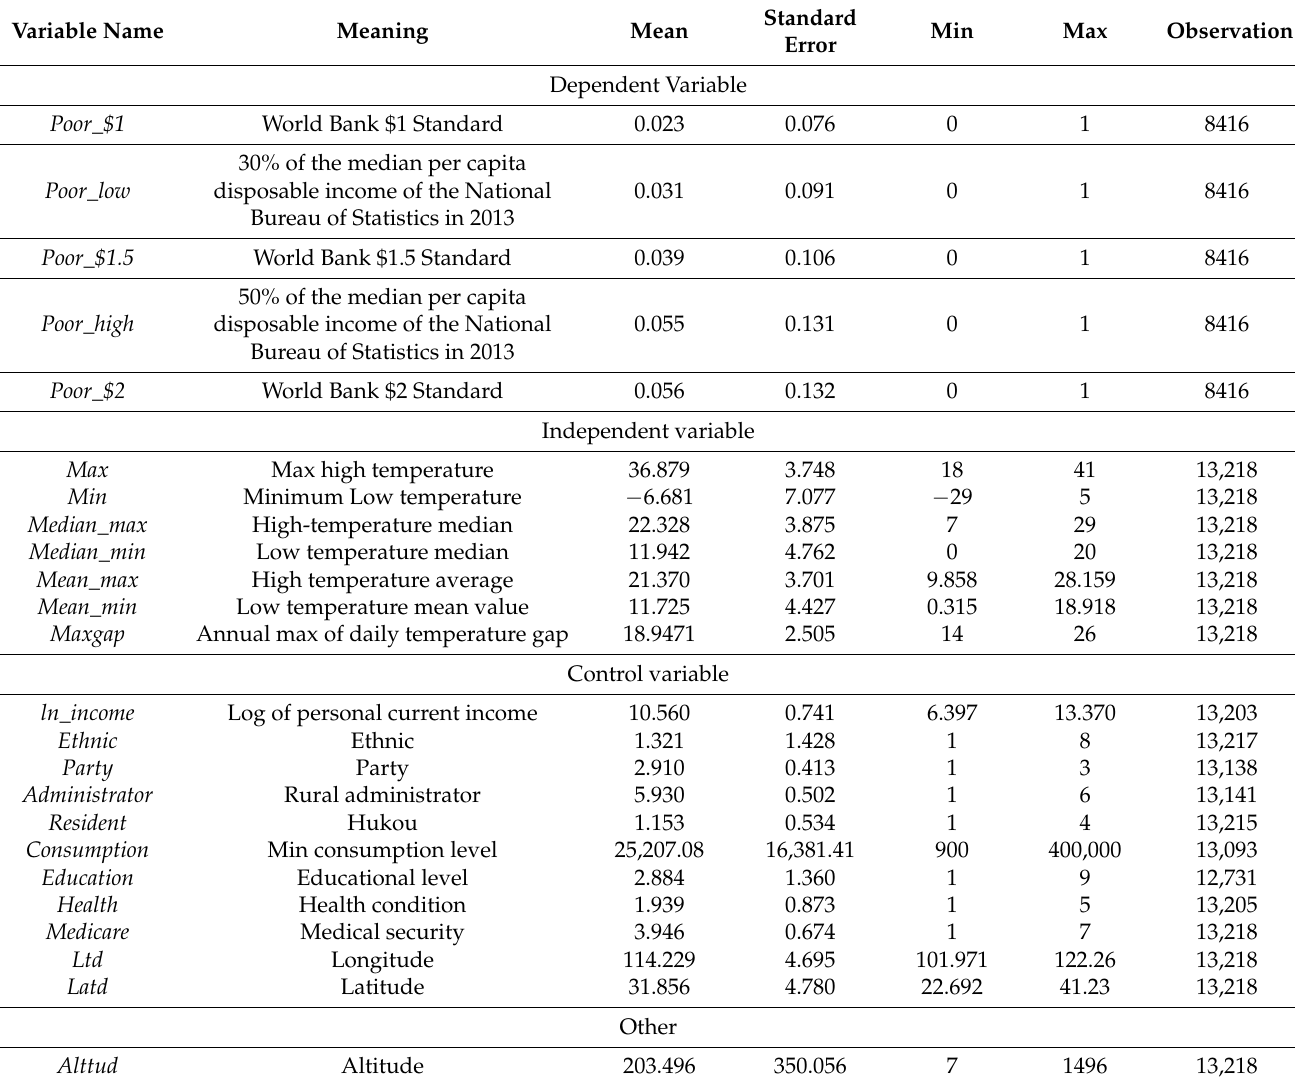
Table 2. Explanation and description of related